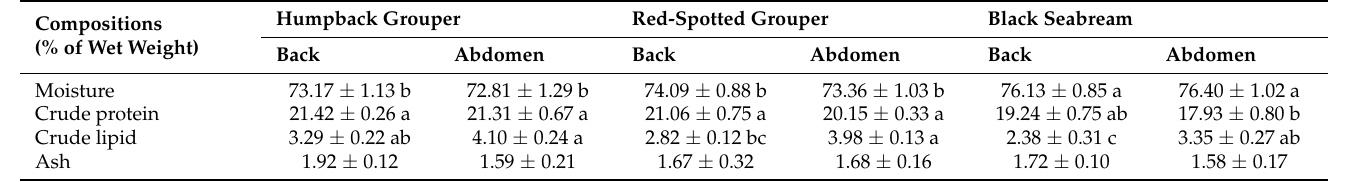
Table 1. Proximate composition of back and abdominal muscles in three perciform